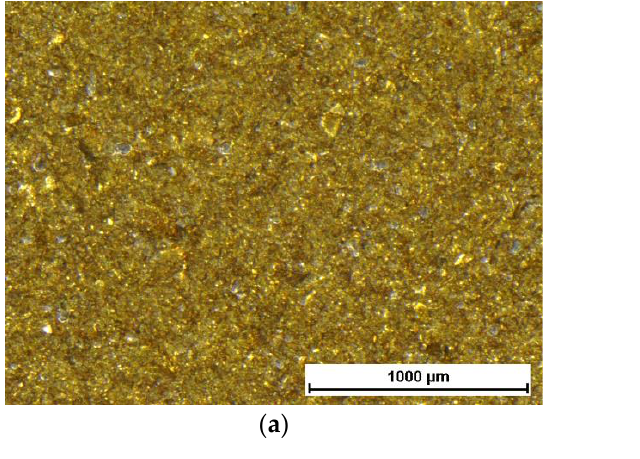
Figure 14. Detail of the blisters in samples A1 ( a ) and A2 ( b ), observed with the optical stereomicro- scope after 500 h of exposure to UV-B radiation.